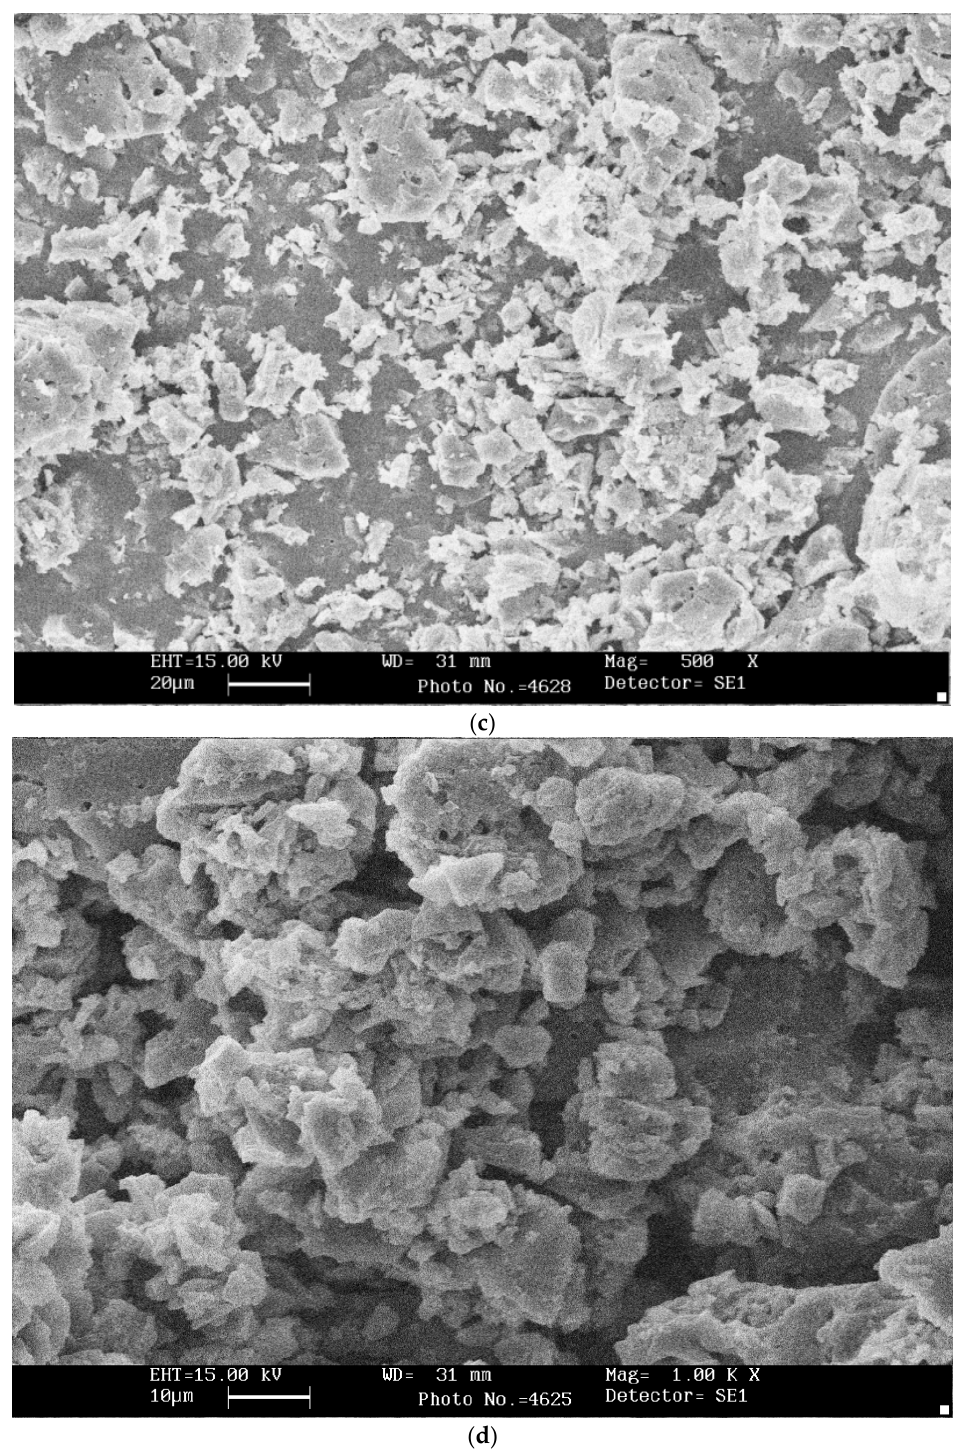
Figure 5. ( a – d ) Scanning electron micrographs (magnification 10,000×) of ( a ) PSW, ( b ) TSW, ( c ) MSW and ( d ) HSW biochars.